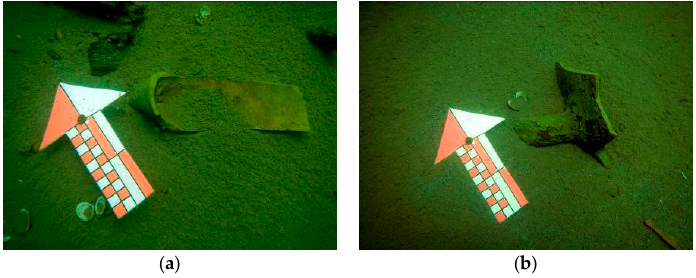
Figure 12. Fragments of Late Roman Amphorae found during underwater surveys in Lago Tramonto, Gambulaga, Portomaggiore (FE, Italy): ( a ) Foot and part of the body of Late Roman 3 ; ( b ) Handle of Late Roman 5 (photo by Giovanna Bucci).